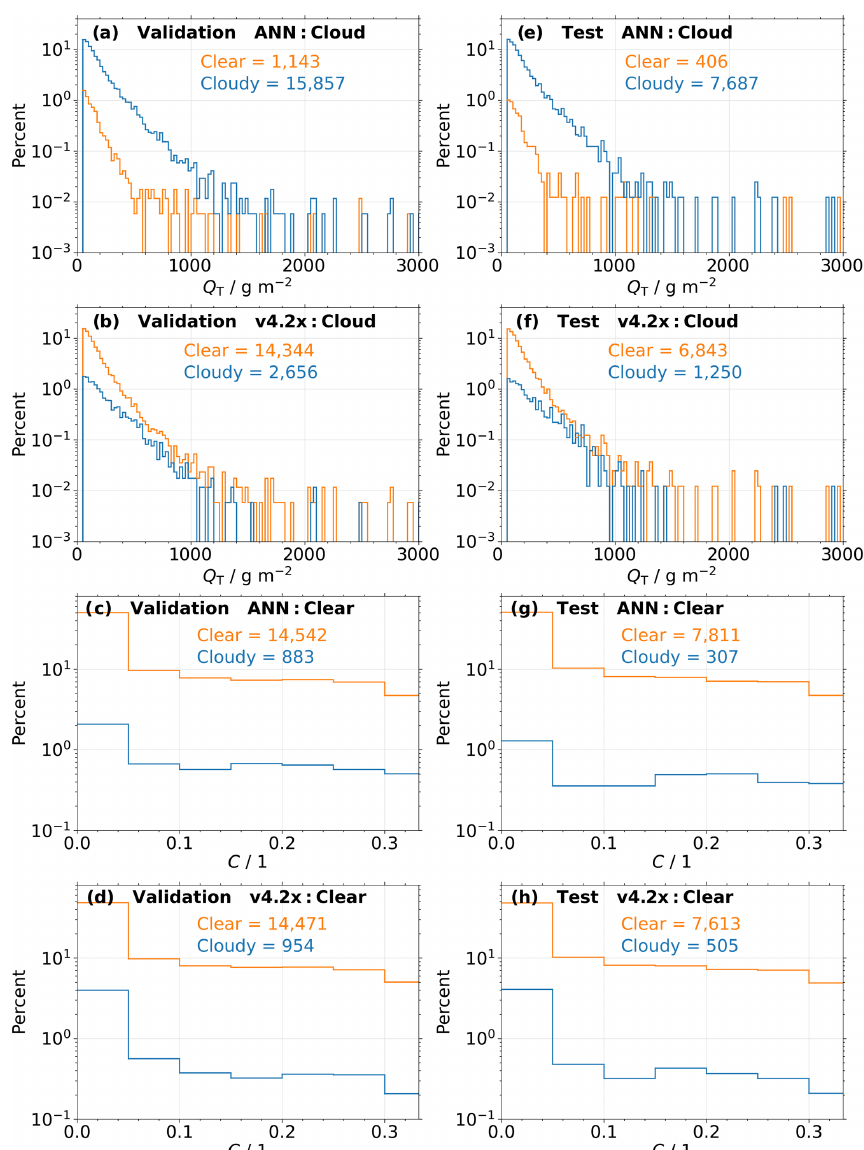
Figure 5. (a) Histograms of cloud classifications from the new ANN-based cloud flag for actually observed cloudy profiles as a function of total water path ( Q T ). Only profiles from the validation data set are considered. Orange and blue colors depict the distributions of predicted clear and cloudy labels, respectively. The number of clear and cloudy predictions is also given. (b) Same as (a) but for classifications from the current v4.2x cloud flag. (c,d) Similar to (a,b) but for actually observed clear profiles as a function of cloud cover ( C ). (e–h) Same as (a–d) but for profiles from the test data